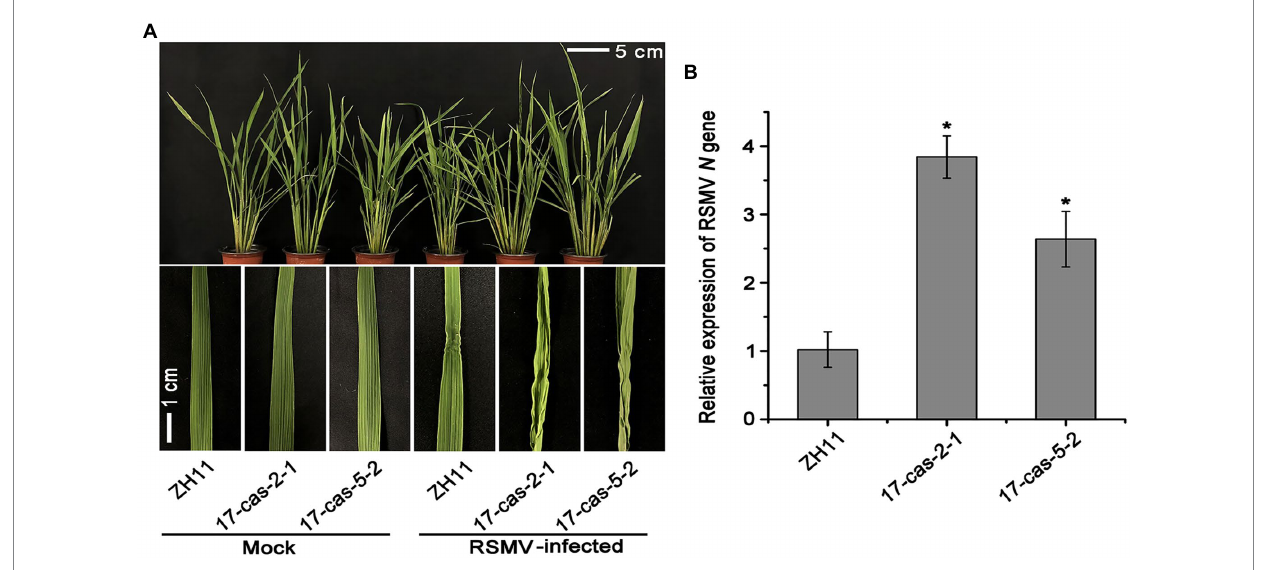
FIGURE 1 OsARF17 mutants showed reduced resistance to rice stripe mosaic virus (RSMV) infection. (A) The phenotypes on RSMV-infected ZH11 and OsARF17 mutant ( 17cas-2-1 and 17cas-5-2 ) plants. The mock-inoculated plants were symptom-free. The symptoms of diseased rice plants were observed and taken photos at 30 days after RSMV inoculation (Scale bars = 5 and 1 cm). Mock, healthy plants; RSMV-infected, RSMV-infected plants. (B) RT-qPCR analysis of the relative expression level of RSMV RNA N gene in RSMV infected ZH11 and OsARF17 mutant plants. * at the top of columns indicate significant differences ( p < 0.05) based on Fisher’s least significant difference